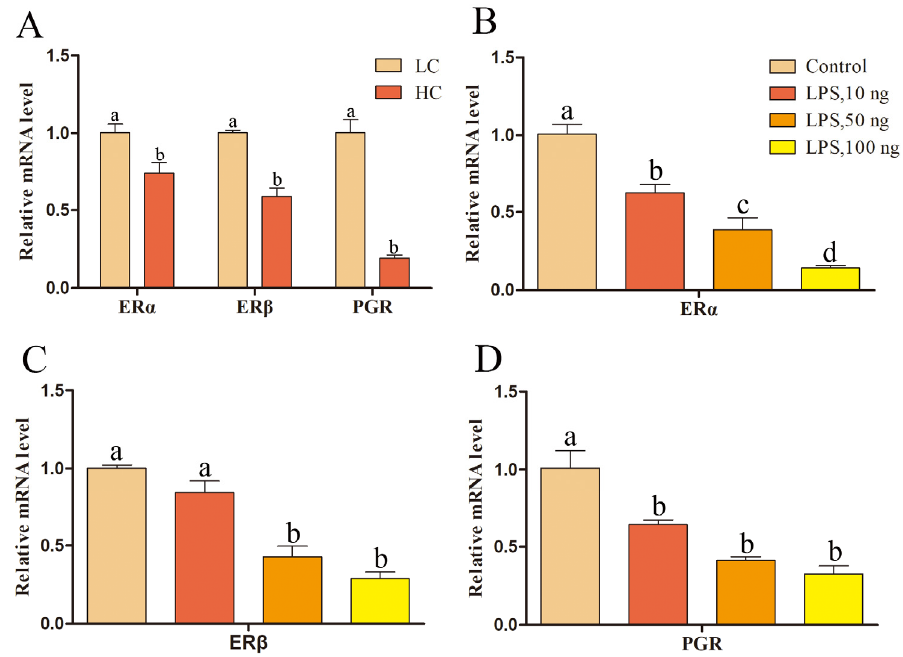
Figure 9. Relative ER α , Er β , and PGR mRNA expression levels in endometrial tissues of the HC and LC groups and effects of LPS-induced epithelial cell inflammation on ER α , ER β , and PGR mRNA expression levels. ( A ) ER α , Er β , and PGR mRNA expression levels of the HC group relative to those of the LC group. ( B ) ER α mRNA expression level in epithelial cells. ( C ) ER β mRNA expression level in epithelial cells. ( D ) PGR mRNA expression level in epithelial cells. Different lowercase letters indicate a significant difference at p < 0.05. LPS, lipopolysaccharide. Concentration is measured in ng/mL.